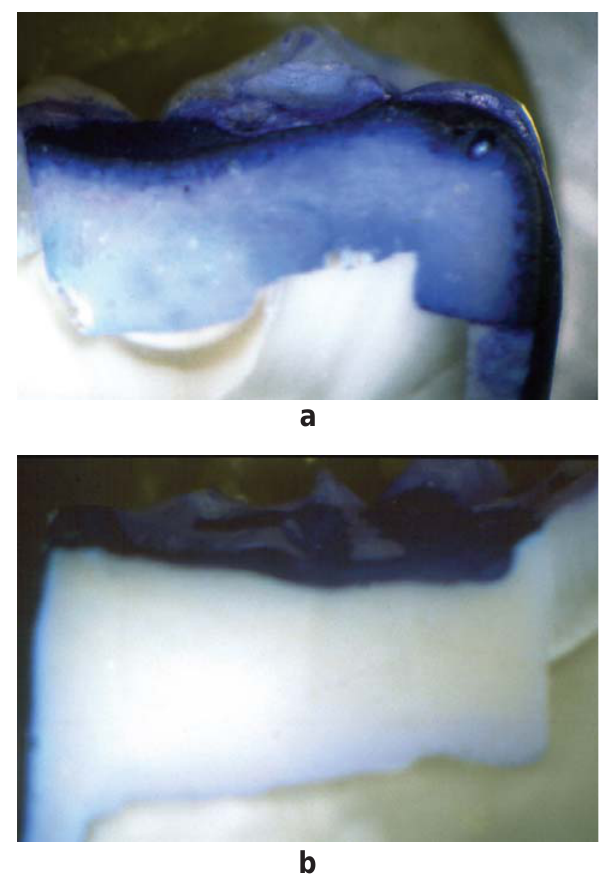
FIGURE 2- pH-dependent erosive wear of conventional and light-curing glass-ionomers.